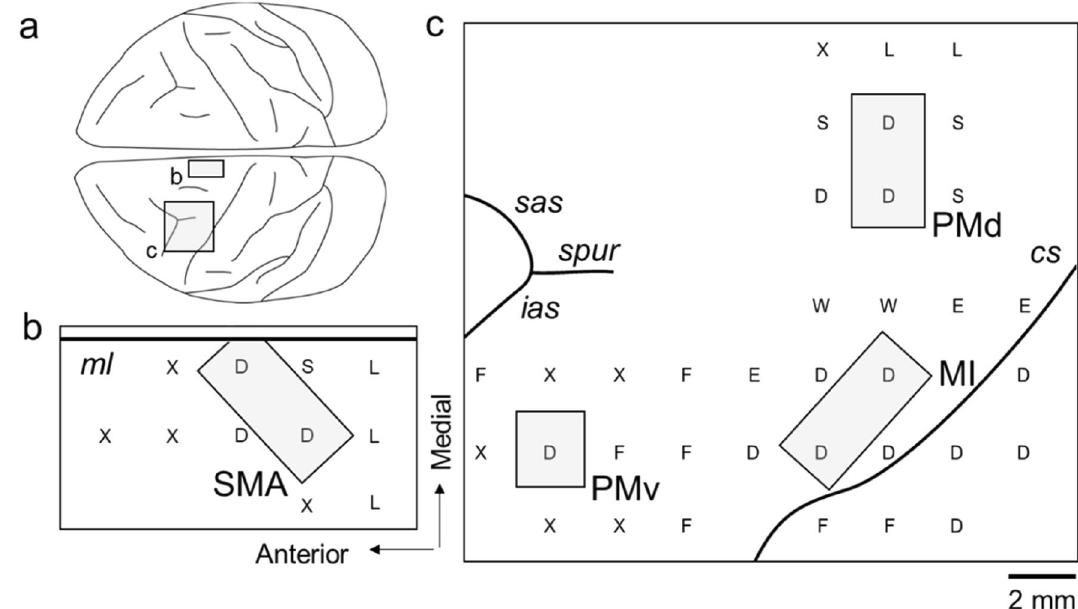
Figure 2. ICMS mapping of frontal motor-related areas. ( a ) Dorsal view of the monkey brain showing the frontal regions examined for ICMS mapping. ( b ) Results of ICMS mapping for identification of the digit representation of the SMA. ( c ) Results of ICMS mapping for identification of digit representations of the M1, PMd, and PMv. The identified digit regions (in gray) are taken for morphological analyses of the large layer V pyramidal neurons. The body parts of which movements were evoked by ICMS are indicated as follows: D, digits; E, elbow; F, face; L, leg; S, shoulder; W, wrist; X, no response. ias, inferior limb of the arcuate sulcus; ml, midline; sas, superior limb of the arcuate sulcus. Other abbreviations are as in Fig.